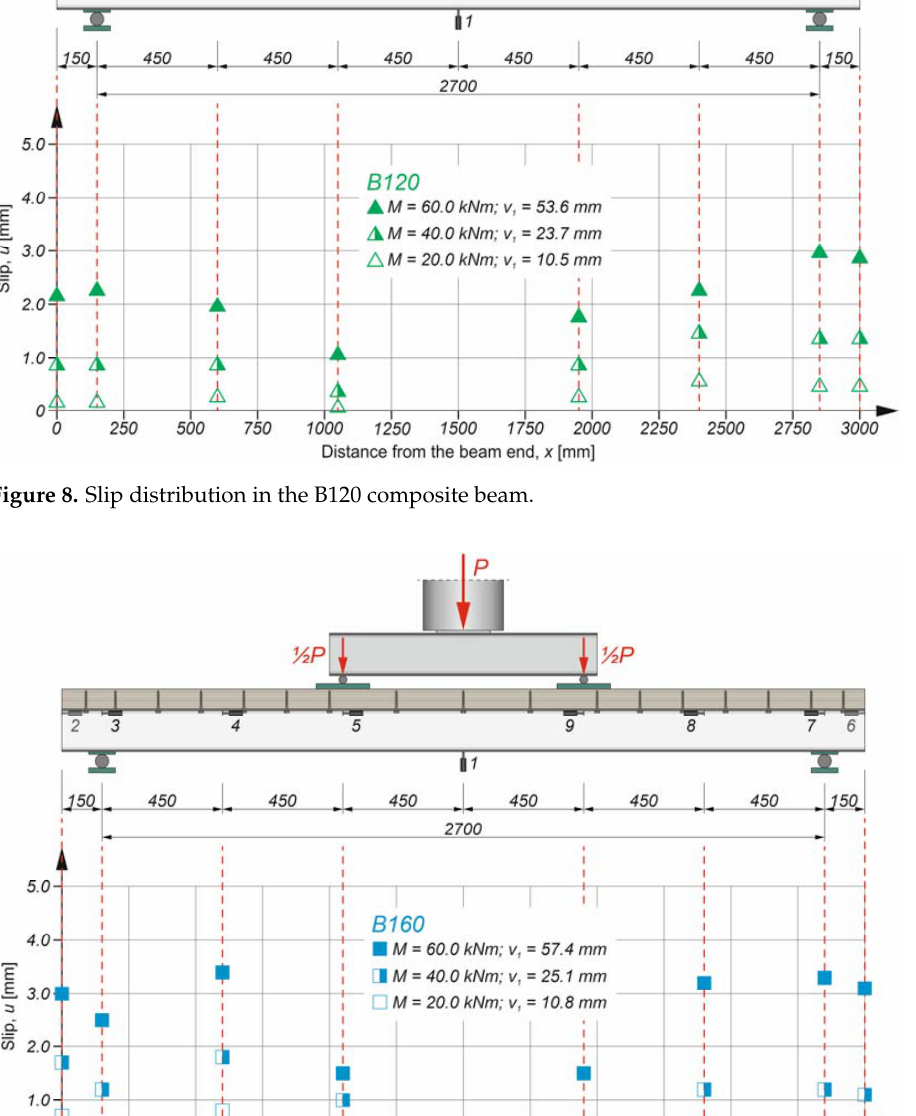
Figure 10. Slip distribution in the B200 composite beam. Figure 11 presents the comparison of the mean slip values in the interface of the an ‐ alysed beams. The mean values of the slip were calculated considering the slip values from the left and right sides of the beams. The degree of shear connection had an impact on the slip value. Beam B200 had the highest slip value, which resulted from the lowest value of the degree of shear connection.